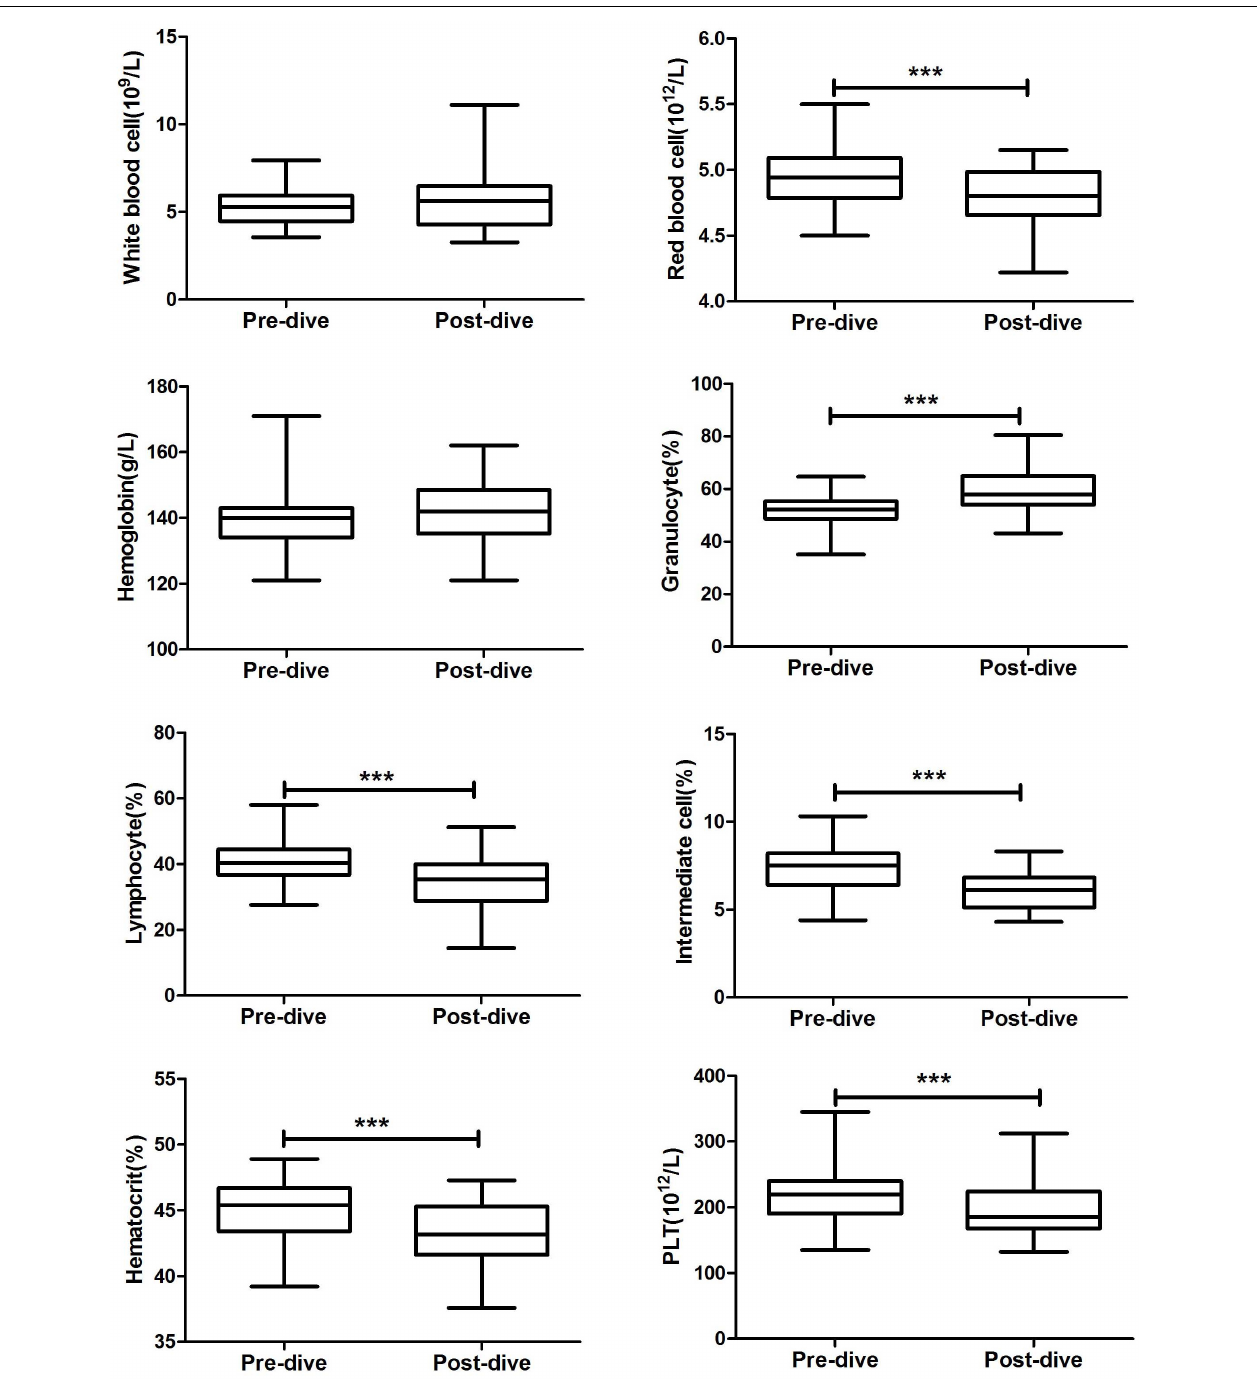
FIGURE 2 | Changes in peripheral blood cells before and after 80 m heliox diving. *** P < 0.0001 compared with predive. Data are means ± SD ( n = 40). The paired-sample t -test (two-tailed) was performed based on the normality of the distribution as checked by using the Shapiro–Wilk test.